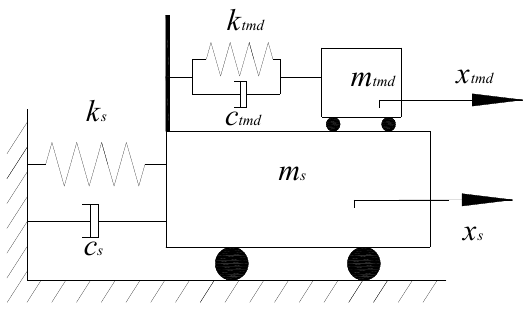
Figure 7. Mechanical model of damped structure with a tuned mass damper (TMD).